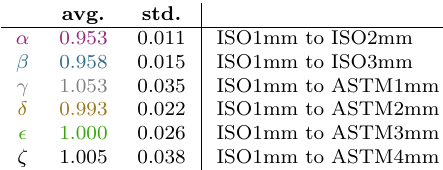
Table 5. Average Kelvin temperature shift factors α , β , γ , δ , (cid:15) and ζ and their standard